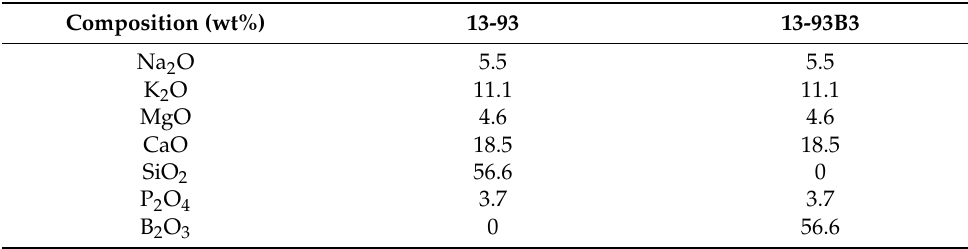
Table 1. Nominal composition of bioactive glasses in